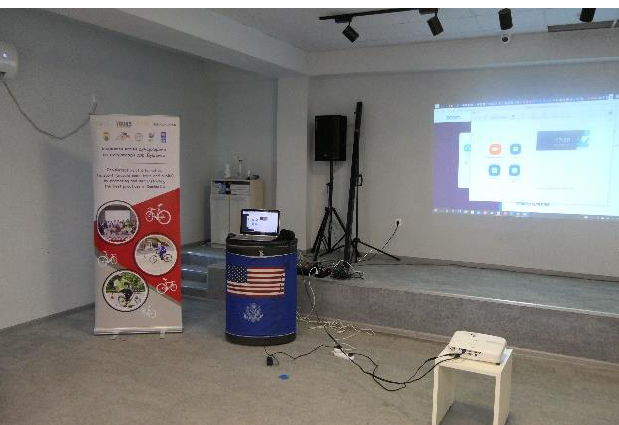
Figure 6. The workshop space provided at the American Space in Dushanbe (courtesy of the Young Generation of Tajikistan).